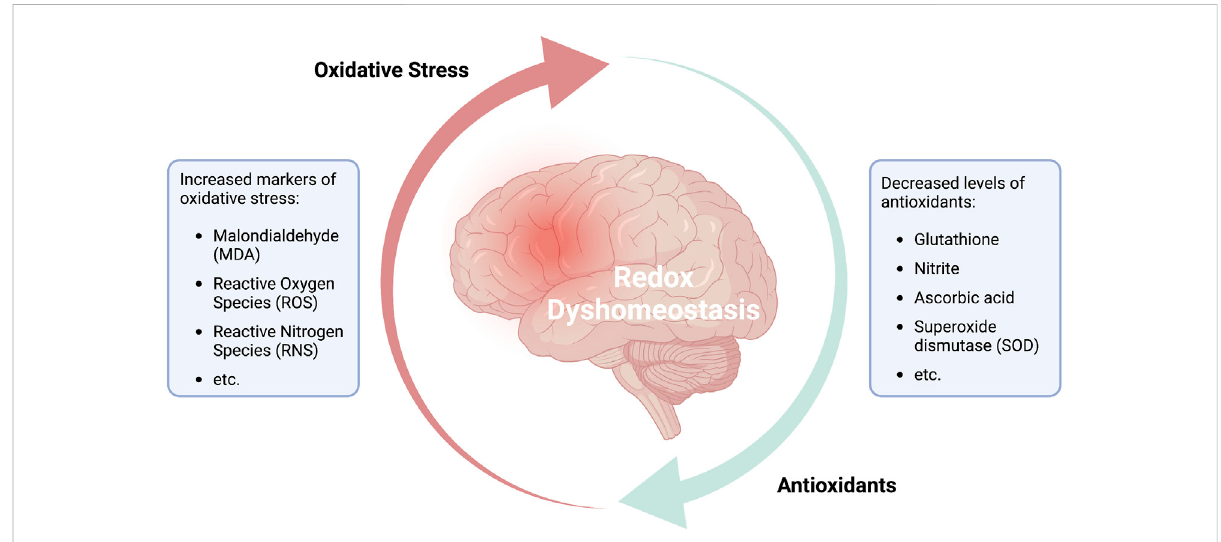
FIGURE 2 Redox dyshomeostasis: a potential predictor for psychiatric